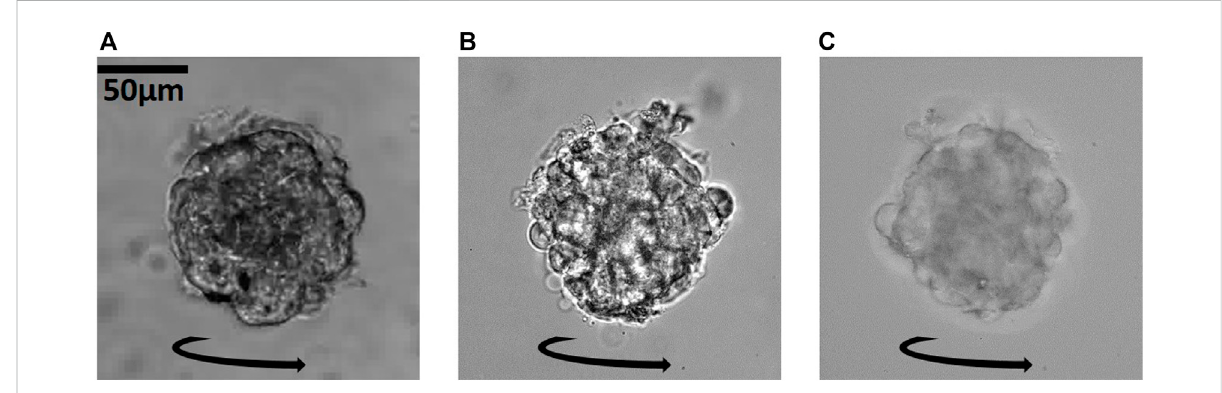
FIGURE 9 Enabling of the 3D inspection of a larger, more spherical cancer spheroid: Increasing the imaging-NA from (A) NA obj = 0.25 to (B) NA obj +